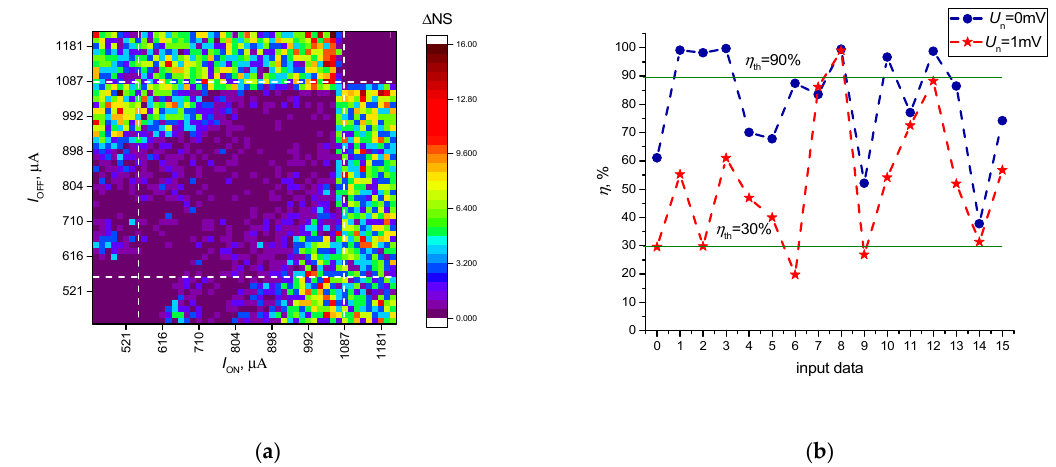
Figure 17. ( a ) The density of distribution of solutions to the “16 of 16” task in the I ON and I OFF current space, dotted lines indicate the boundaries of the areas (area 1, area 2, area 3 in accordance with Figure 11). ( b ) The dependence of the synchronization efficiency η on the input data (in decimal format) at two amplitudes of internal noise U n .